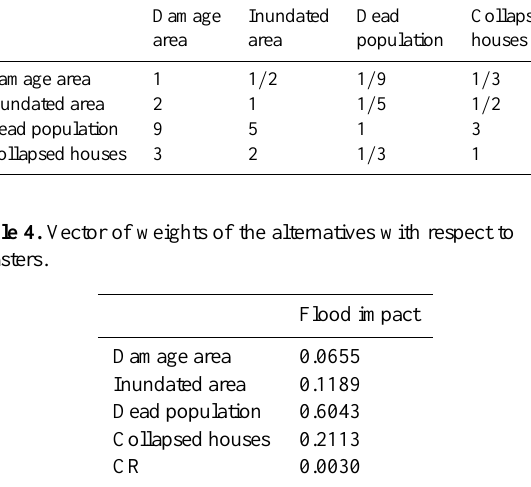
Table 5. The disaster degree values during the 60yr in China.